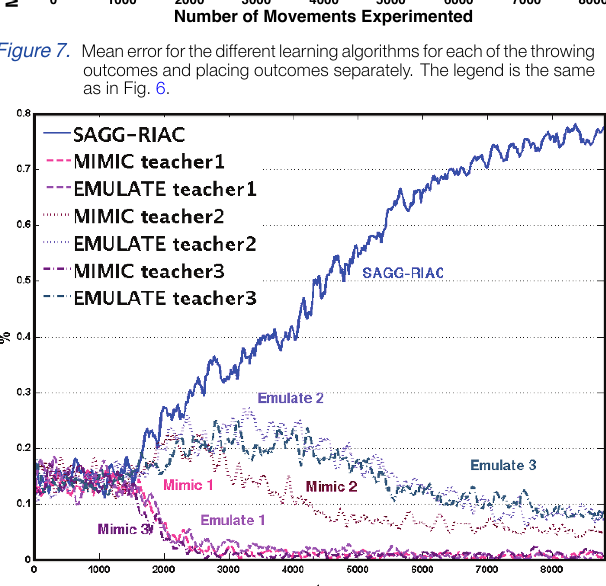
Figure 9. Outcome chosen by SGIM-ACTS through time: percentage of times each kind of outcome is chosen for several runs of the experiment.